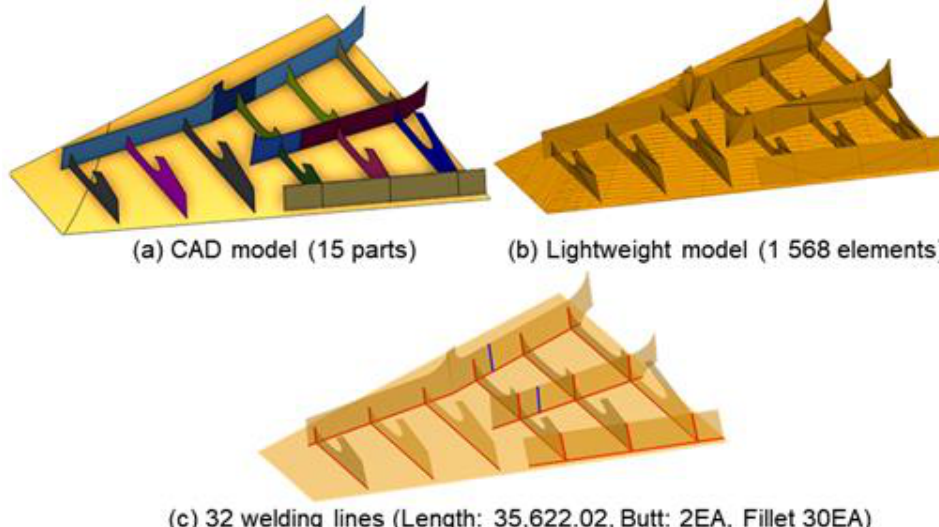
Figure 13. Weld line generation from a block with curved plates.